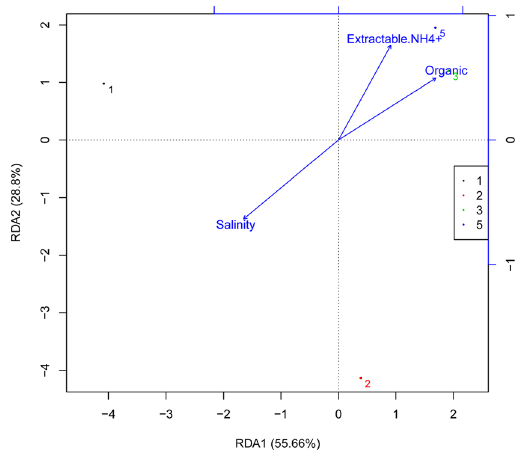
Figure 5. Redundancy analysis (RDA) plot to investigate the correlation between the DNRA bacteria distribution and dominant environmental